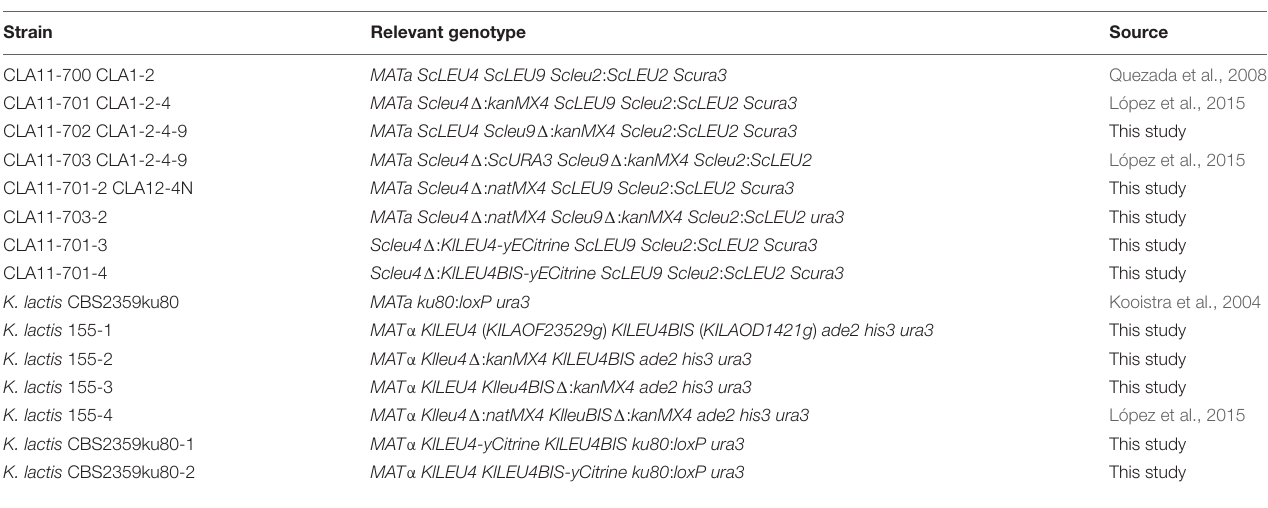
TABLE 1 | Strains used in this